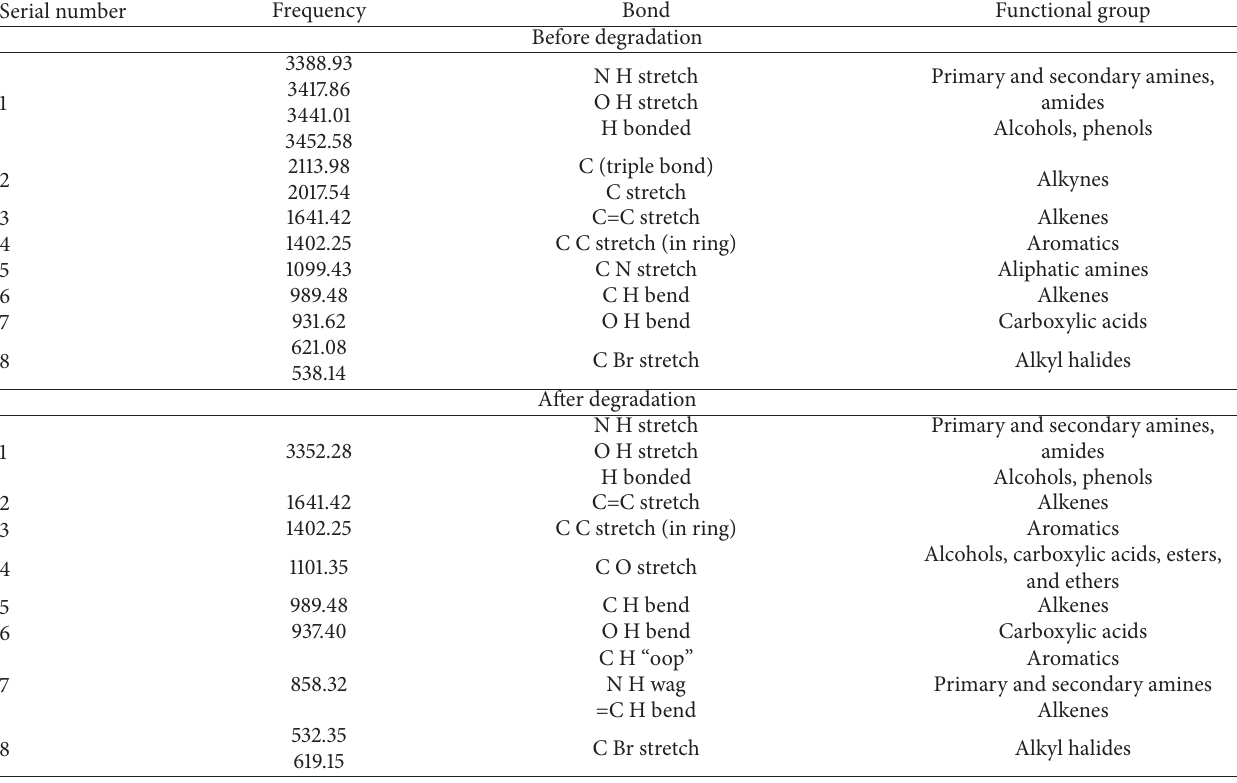
Table 1: Table showing frequencies obtained in FTIR and their corresponding functional groups before degradation and after degradation of toluene.